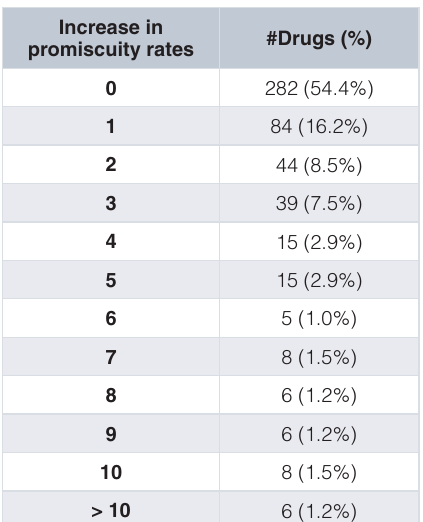
Table 2. Increasing